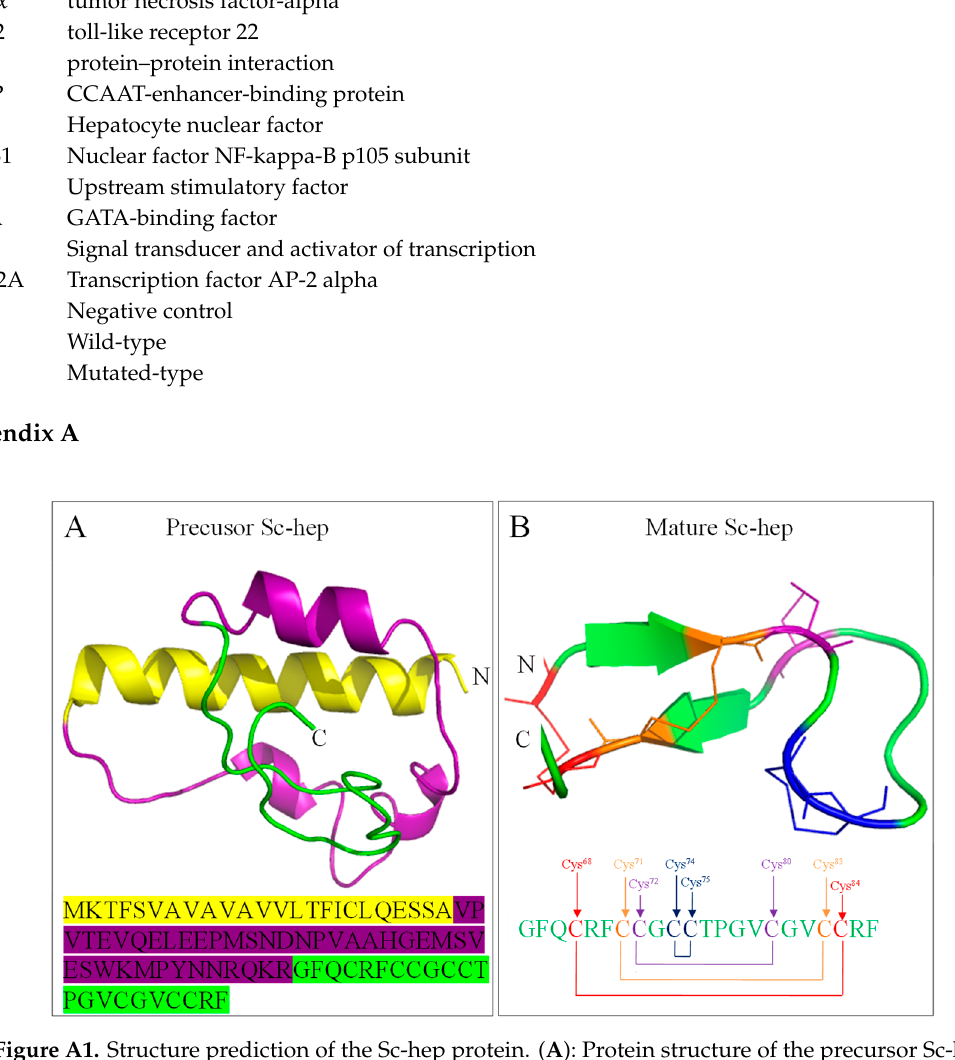
Figure A2. Analysis of iron balance and immune-related genes. ( A ): Protein–protein interaction analysis. The interactions among hepcidin (HAMP), FPN1, TFR1, FTN, IL-1 β , IL8, TNF- α , and SOCS3 proteins were analyzed using a human model. The spheres and lines represent proteins and interactions. The light blue, pink, olive, and black lines represent the analysis from the database, experimental data, text mining data, and co-expression data, respectively. ( B ): Model diagram of iron balance mechanism. Transferrin (TF) carries Fe 3+ and binds to TFR1. In this process, Fe 3+ is changed to Fe 2+ by other accessory proteins, and Fe 2+ is transported into cells by TFR1. FTN can store excess Fe 2+ in the cells. Fe 2+ is exported outside of the cells via FPN1. In this process, Fe 2+ is changed to Fe 3+ by other accessory proteins. Fe 3+ is then carried by TF and transported by blood to the site where it is stored or needed. HAMP binds to FPN1, internalizes, and degrades FPN1 to block iron output.